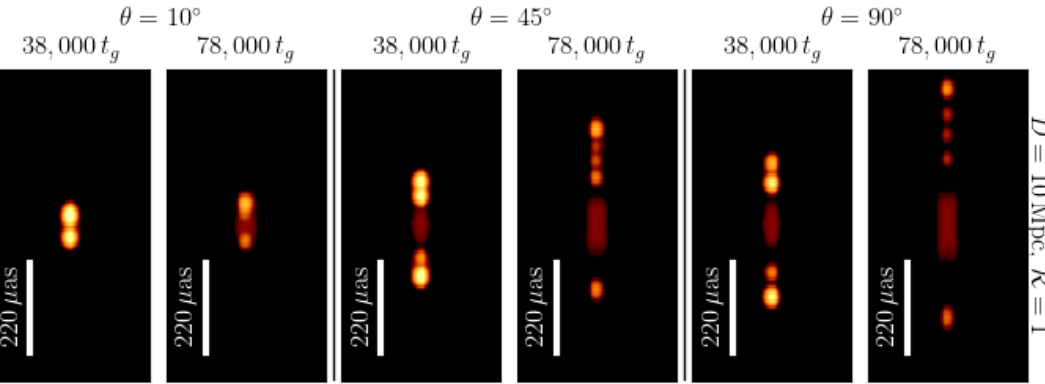
Figure A1. Here we show the full library of base ipole images for model m7a0.0-HR. The time of each column is indicated at the top; the distance D and plasma temperature ratio R for each row are indicated on the right. The angle of the observer relative to the jet axis is indicated above each set of two rows. Each image spans 550 × 770 µ as 2 and is blurred by convolving the base image with a Gaussian beam with a FWHM of 20 µ as. The color scale is logarithmic, spanning three orders of magnitude, and each image uses the same maximum for the intensity